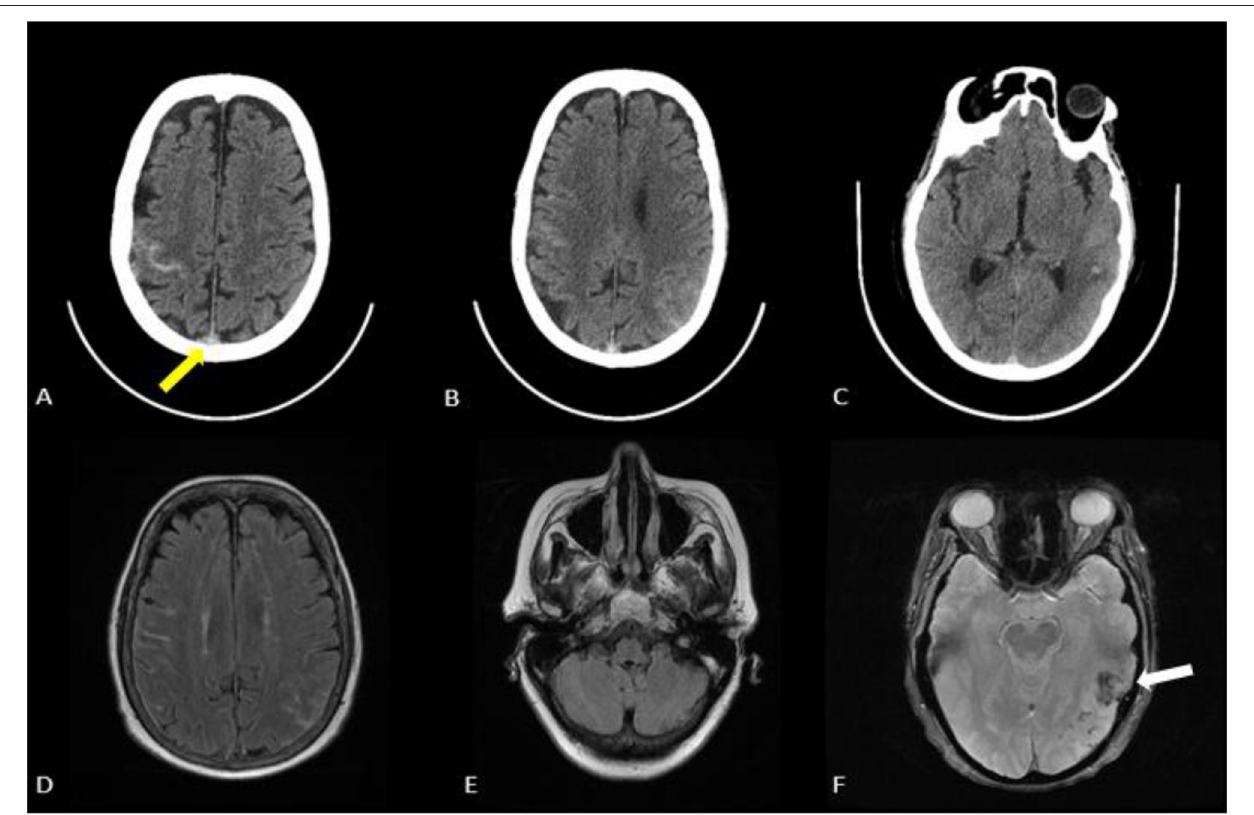
FIGURE 1 | (A–C) CT head revealing acute multicompartment hemorrhages with left temporal parietal intraparenchymal hemorrhage measuring approximately 3cm, right frontal subarachnoid hemorrhage and left parietal subarachnoid hemorrhage. No midline shift noted. Hyperdense sign noted (yellow arrow) in the superior sagittal sinus suggesting venous sinus thrombosis. (D,E) MRI brain without contrast FLAIR sequence with right frontal hyperintensity and left parietal hyperintensity consistent with subarachnoid hemorrhage. (F) Left temporal blooming noted (white arrow) on the GRE sequence consisted with intraparenchymal